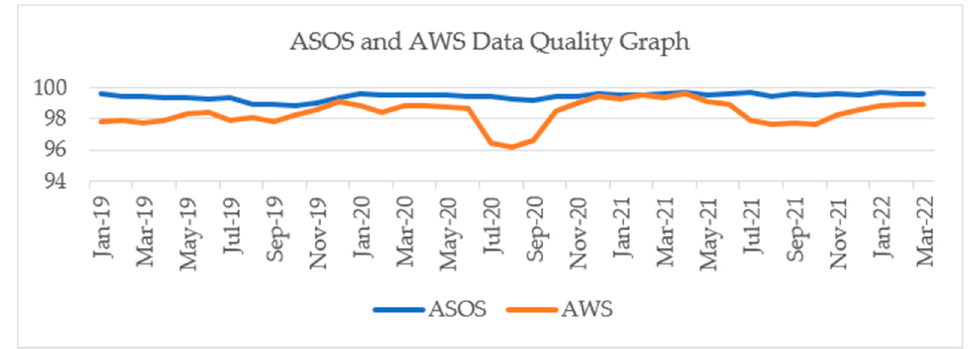
Figure 5. Automated Synoptic Observing System (ASOS) and Automatic Weather System (AWS) Data Quality Graph.